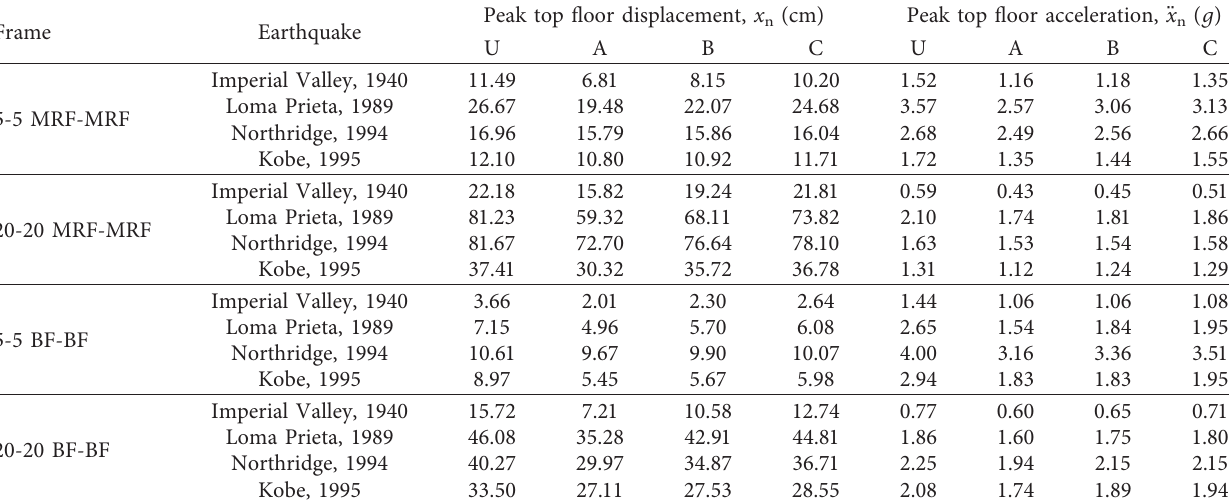
Table 6: Peak top floor displacement and acceleration responses of similar connected buildings for equal storey height under historical earthquake ground